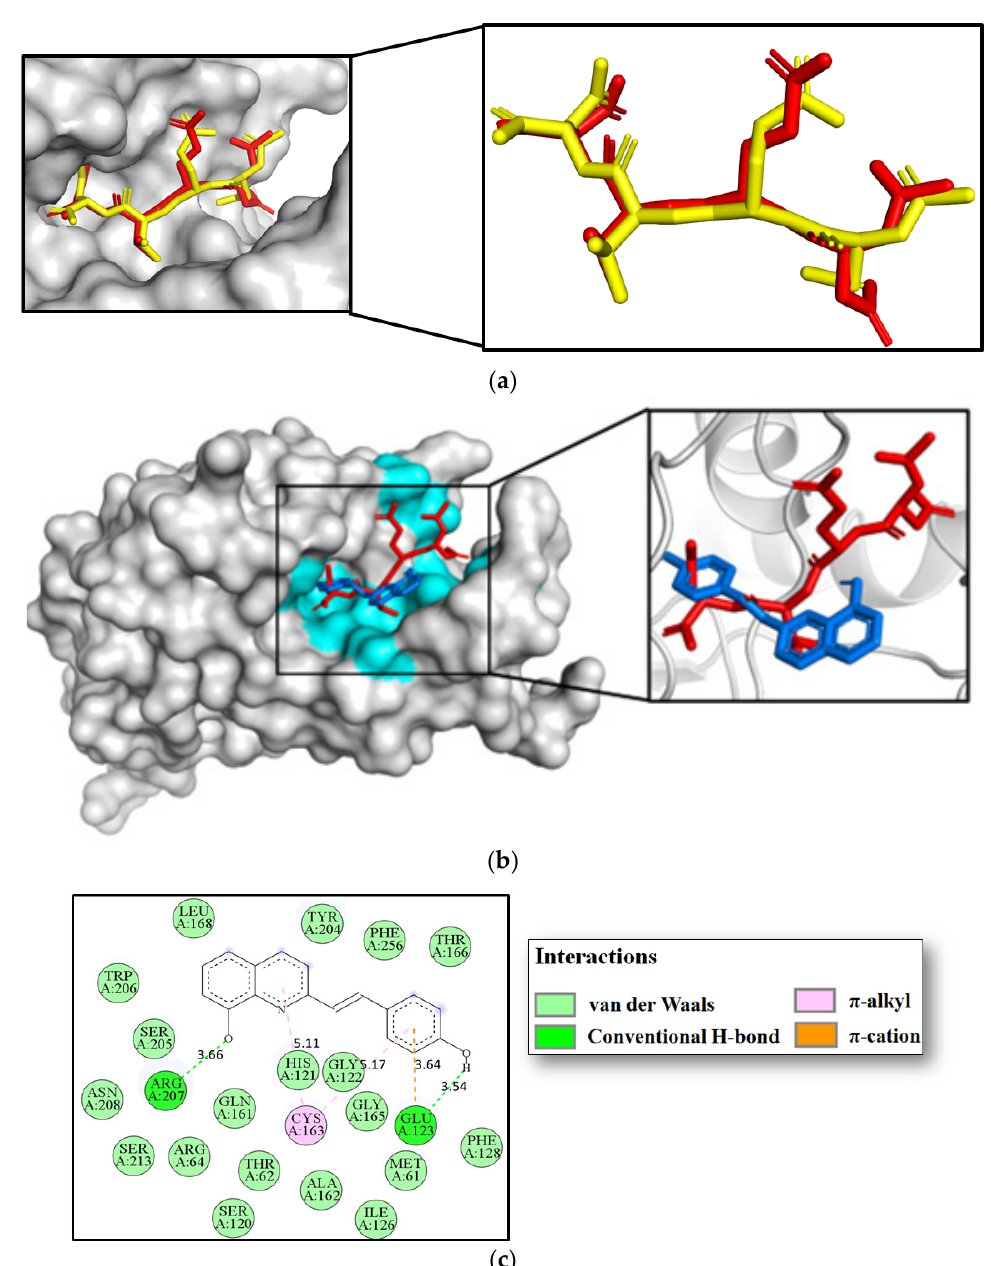
Figure 6. Docking studies of the 3a -caspase-3 complex. ( a ) Self-docking study. 3D superposition of the best-docked pose of Ac-DEVD-CMK (in yellow) and its crystallographic binding pose (in red). ( b ) Alignment of the best-docked conformation of 3a (in blue) and crystallographic binding mode of inhibitor Ac-DEVD-CMK (in red) within the caspase-3 catalytic domain. ( c ) 2D interaction diagram between 3a and caspase-3. Hotspot amino acid residues are colored in cyan.